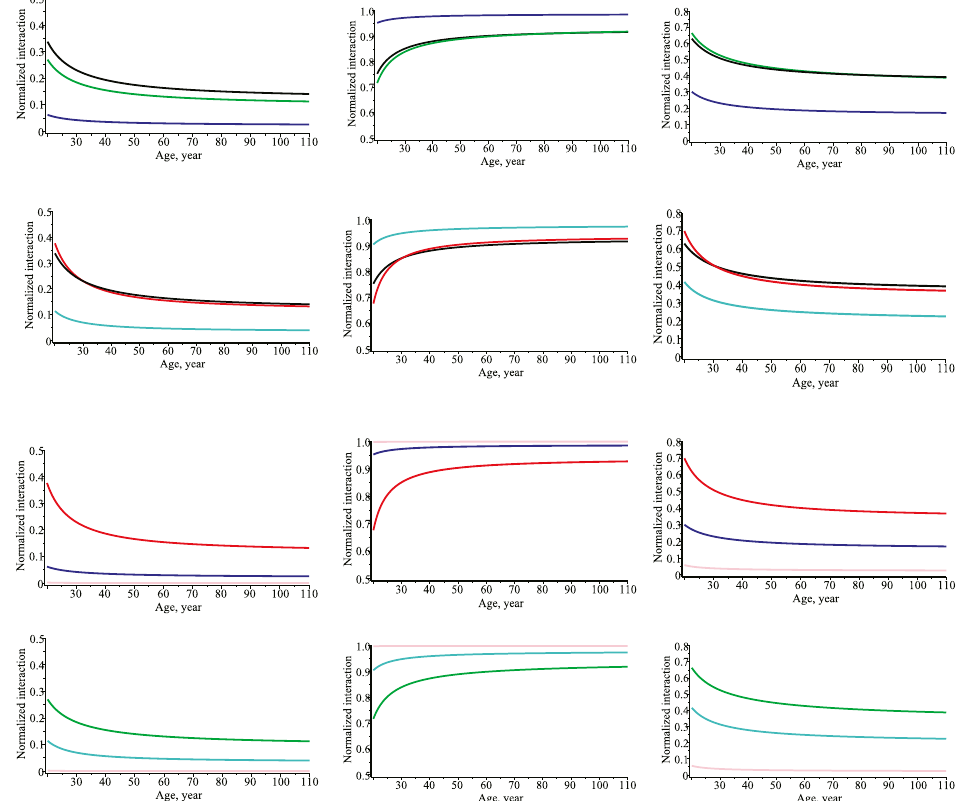
Figure 4. Evolution of bivariate normalized mutual information (Equations (51)–(53)). Left column–Equation 51. Middle column–Equation (52). Right column—Equation (53). First row for diameter as a response variable and predictors: black—height; blue—crown base height; green—crown width. Second row for height as a response variable and predictors: black—diameter; red—crown base height; cyan—crown width. Third row for crown base height as a response variable and predictors: blue—diameter, red—height, pink—crown width. Fourth row for crown width as a response variable and predictors: green—diameter, cyan—height, pink—crown base